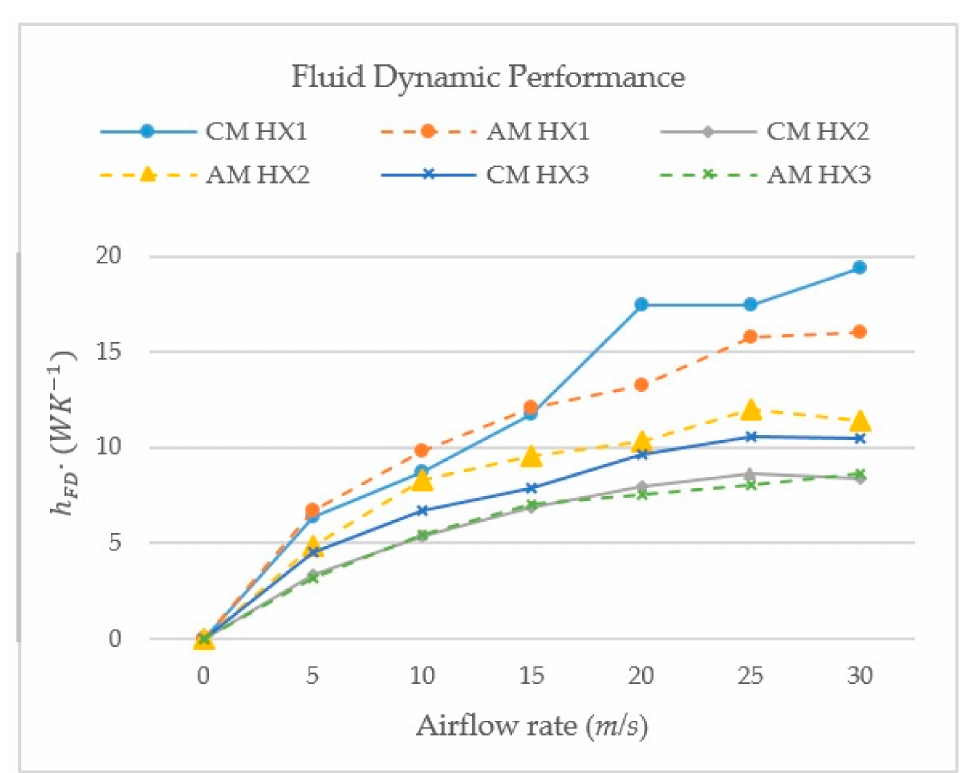
Figure 8. Experimental thermal fluid dynamic performance of HXs when the heater temperature was 50 ◦